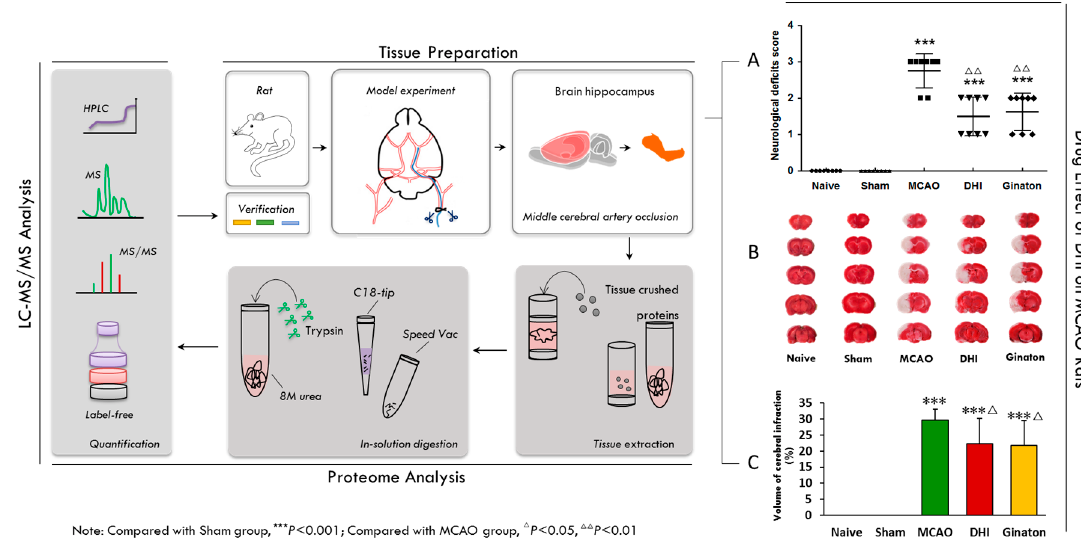
Figure 1. Overview of the experimental workflow. Firstly, permanent occlusion of the middle cerebral artery (MCAO) was established in rats with an intraluminal silicon-coated filament (tissue preparation). Secondly, to ensure the reliability and rationality of the rat model of cerebral ischemic injury, an initial experiment revealed the success of the establishment of focal ischemic models (A,B,C). Thirdly, the hippocampal region of the model brains was tissue crushed and the protein extracted, after injury time of 24 h in focal ischemic models (tissue preparation). Fourthly, proteins for proteome analysis were tryptic digested in solution, desalted using a C18 pre-column, and subjected to LC and Q-Exactive analysis (proteome analysis). Finally, the peptide mixture was analyzed with online reverse-phase chromatography and mass spectrometry and a label-free approach was used for the quantitative analysis (LC-MS/MS Analysis). ( A ) The results of neurological deficits Score shown that DHI and Ginaton can improve neurological function in MCAO rats after 24 h ischaemic injury (Table 1, the date was tested by a rank sum test); ( B , C ) 2% TTC staining results and histogram shown that DHI and Ginaton can decrease the volume of cerebral infraction in MCAO rats. The results of TTC were tested by one way ANOVA and multiple testing (Table 2).